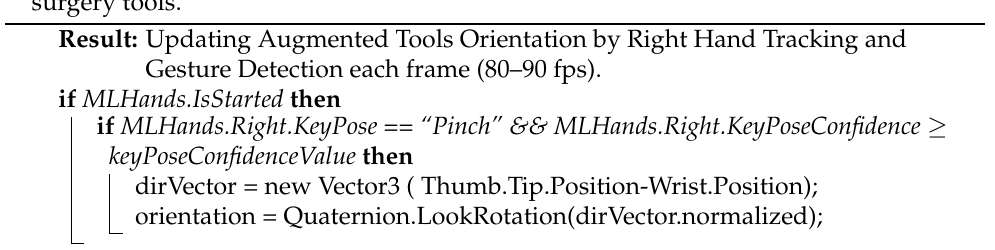
Figure 5. Interaction activity on Magic Leap handling tweezers and needle holder. The left image shows the tweezer’s interaction with the first interactive point of a stitch. The center image depicts the enabling of the following stitch in the wound. The right image illustrates the needle-holder’s interaction with the second interactive point of a stitch. Algorithm 1: Position orientation right hand-tracking algorithm of augmented surgery